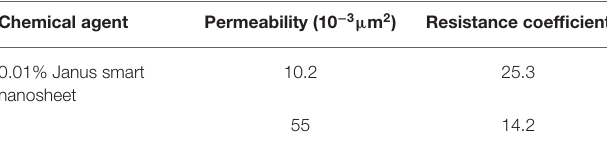
TABLE 5 | Data sheet of resistance coefficient of nanosheet drive after water flooding.